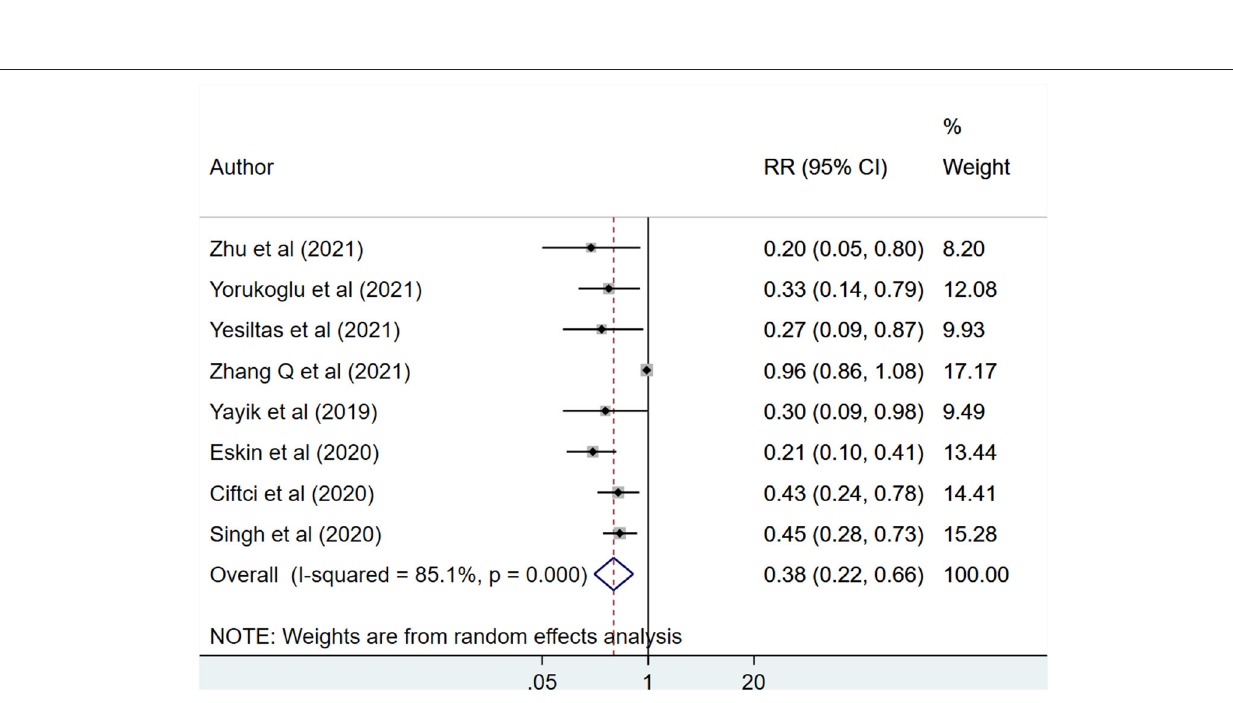
FIGURE 3 | Risk for need of rescue analgesia among subjects with erector spinae plane block, compared to placebo or no block.